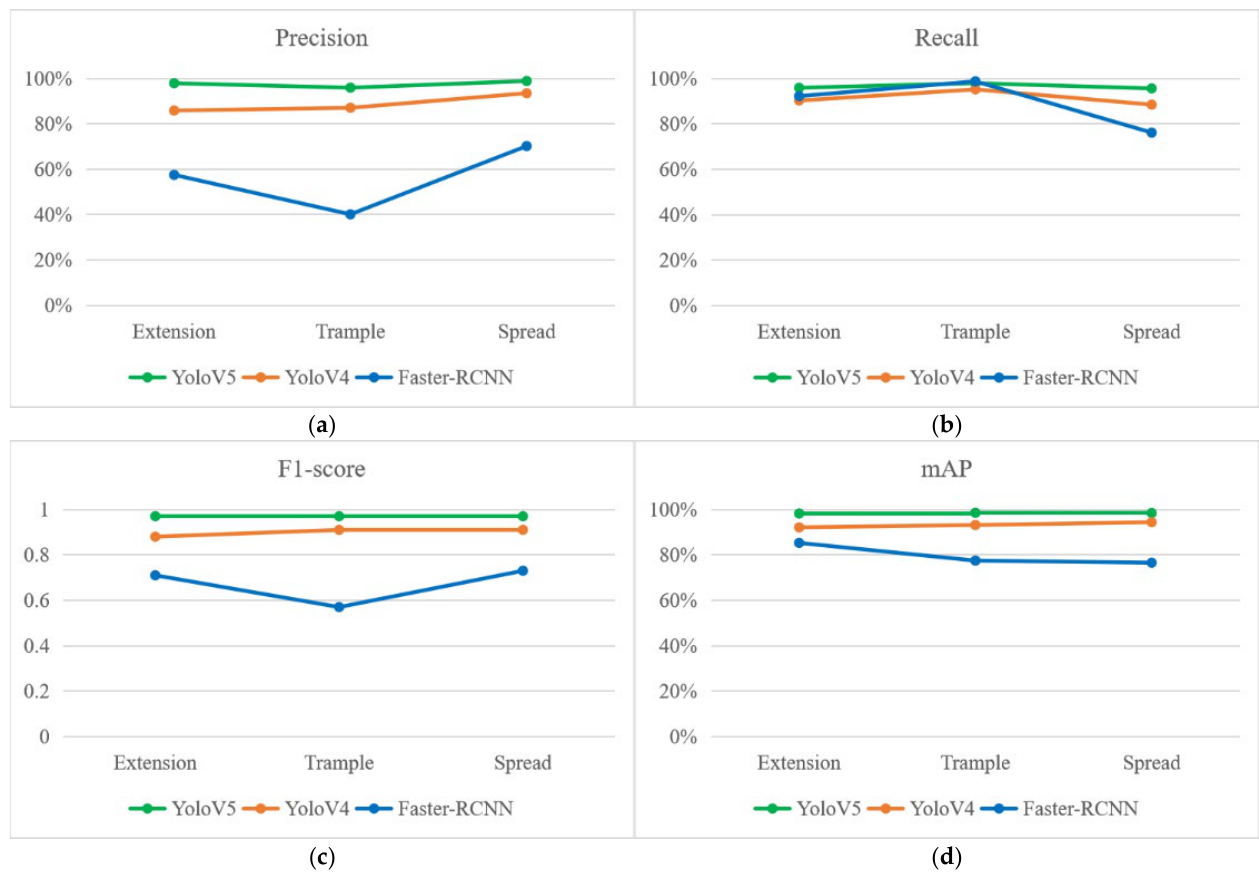
Figure 12. The results of different algorithms. ( a ) chart of precision of three behaviors, ( b ) chart of recall of three behaviors, ( c ) chart of F1-score of three behaviors, ( d ) chart of mAP of three behaviors.